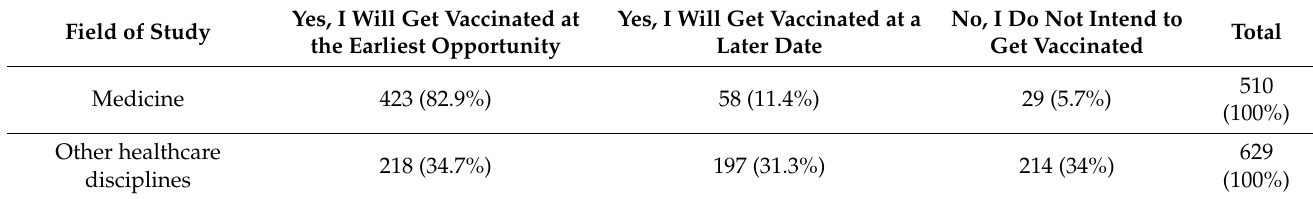
Table 3. Vaccination intention among medical and other healthcare